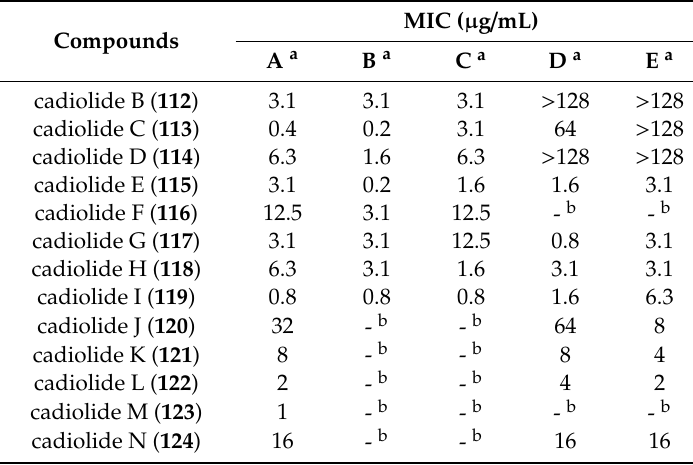
Table 2. MIC values ( µ g / mL) of cadiolides B–N ( 112 – 124